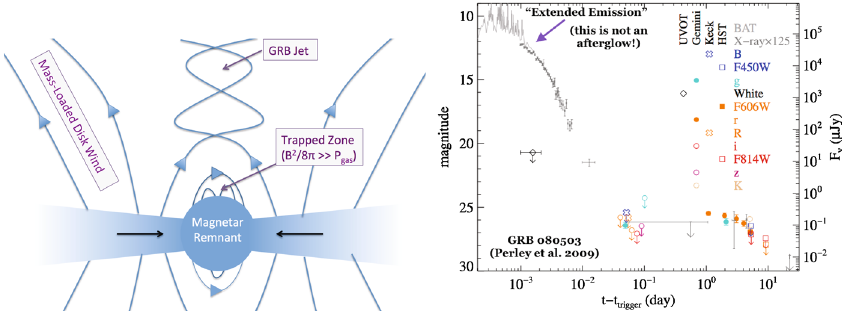
Fig. 9 Left schematic illustration of a possible scenario by which accretion onto the magnetar remnant of a NS–NS merger could power an ultra-relativistic short GRB jet. Strong magnetic fields in the polar region confine the hot atmosphere of the proto-NS (Thompson 2003), preventing the formation of a steady neutrino-driven wind in this region. Open magnetic field lines, which thread the accretion disk or shear boundary layer, carry the Poynting flux powering the GRB jet. These field lines are relatively devoid of baryonic matter due to the large centrifugal barrier, enabling the outflow to accelerate to attain high asymptotic Lorentz factors. At larger radii in the disk, outflows will be more heavily mass-loaded and form a potential collimating agent for the jet. Right X-ray and optical light curves following the short duration GRB 080503. Note the sharp drop, by over 6 orders of magnitude, in the X-ray flux, within hours following the burst. This ‘steep decay phase’, often observed following the prompt emission in long duration GRBs, is probably not related to the ‘afterglow’ (forward or reverse shock created by the jet interacting with the circumburst medium), instead requiring ongoing central engine activity. Image reproduced with permission from Perley et al. (2009), copyright by